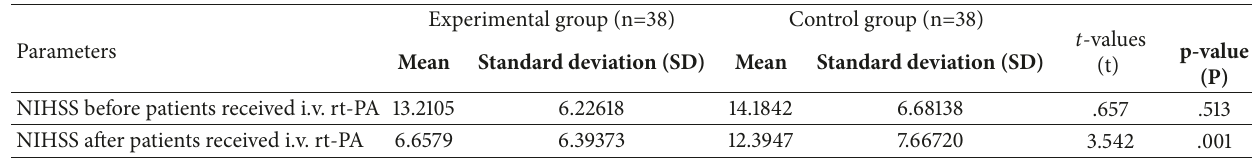
Table 4: Mean and SD of NIHSS in experimental and control groups before and after receiving i.v. rt-PA within 24 hours by independent sample t -test analysis.